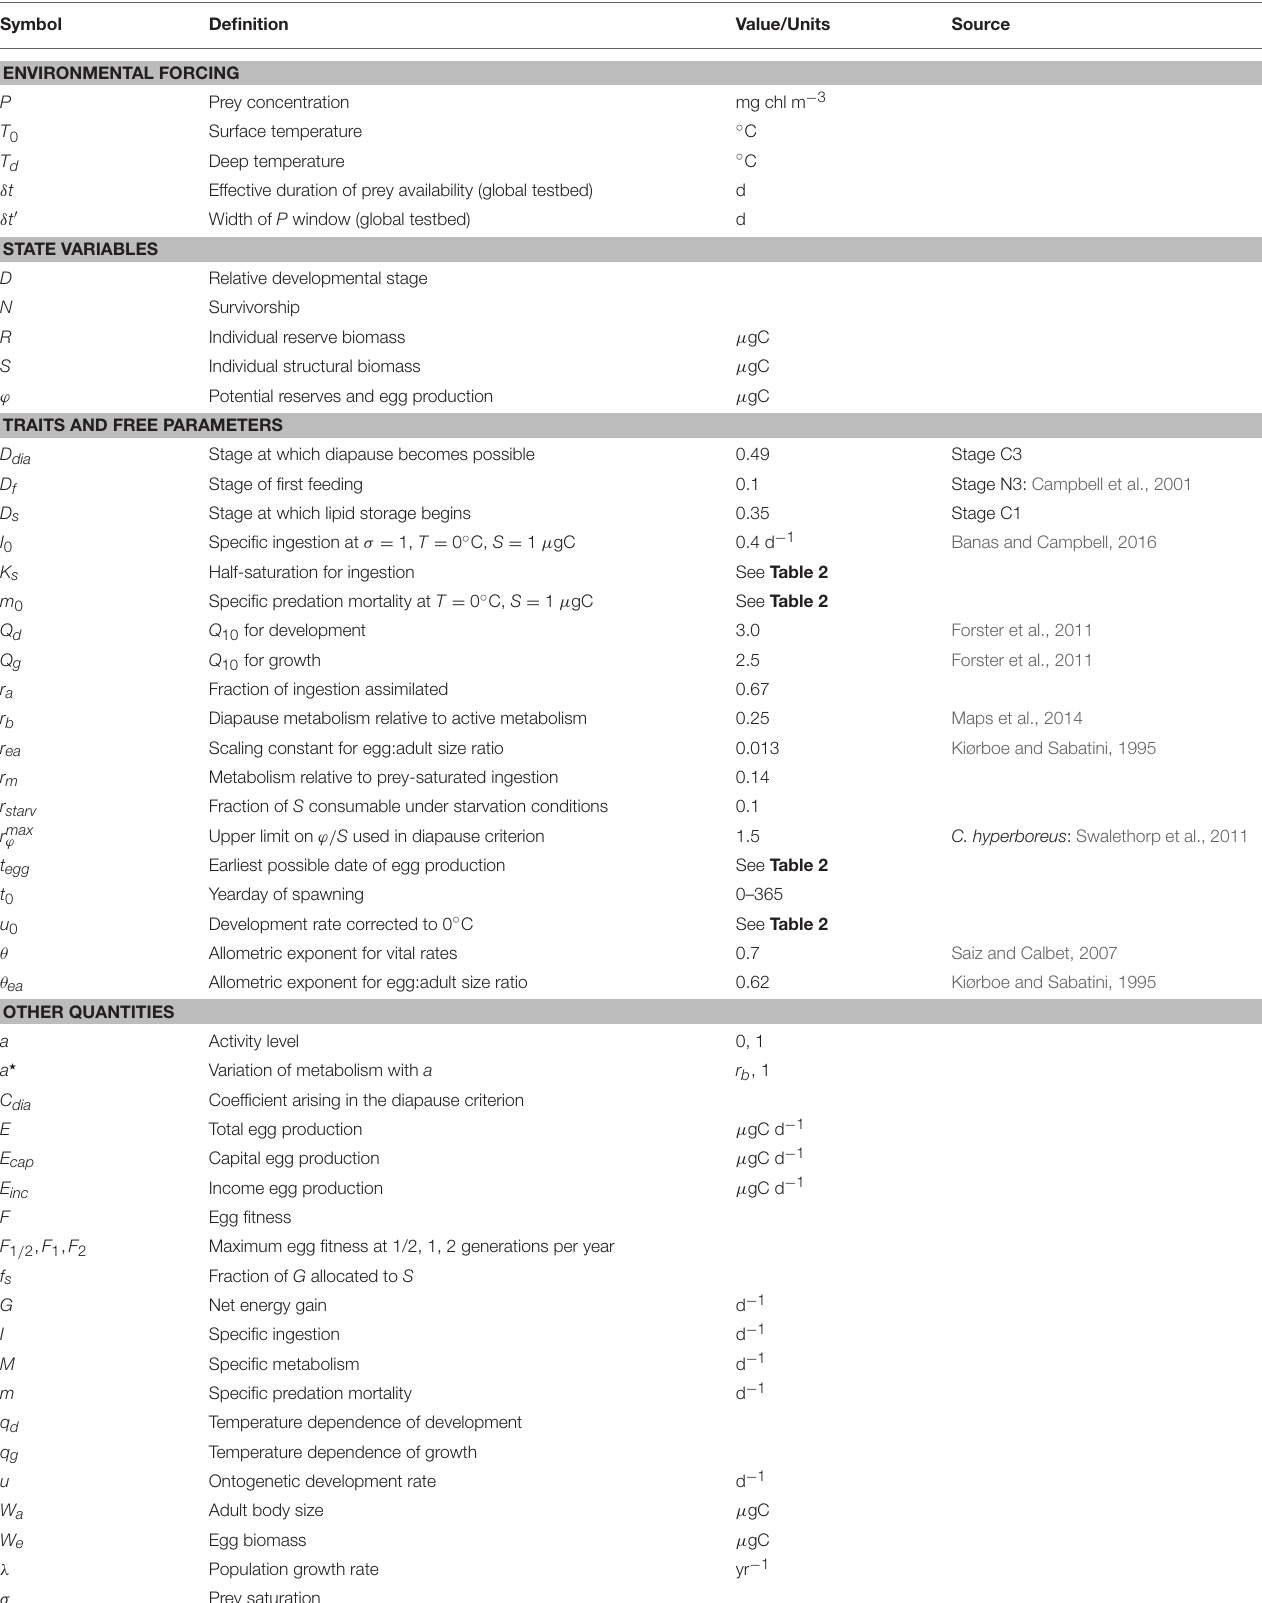
TABLE 1 | Parameter values and other symbols used in the manuscript.